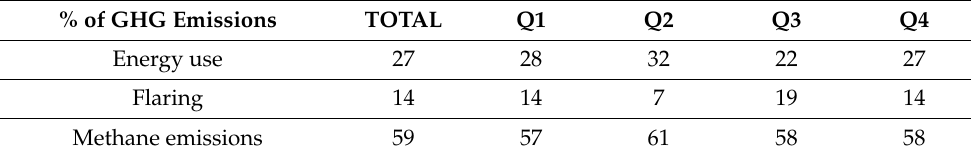
Table 2. Distribution of global aggregate CO2 emissions from upstream oil